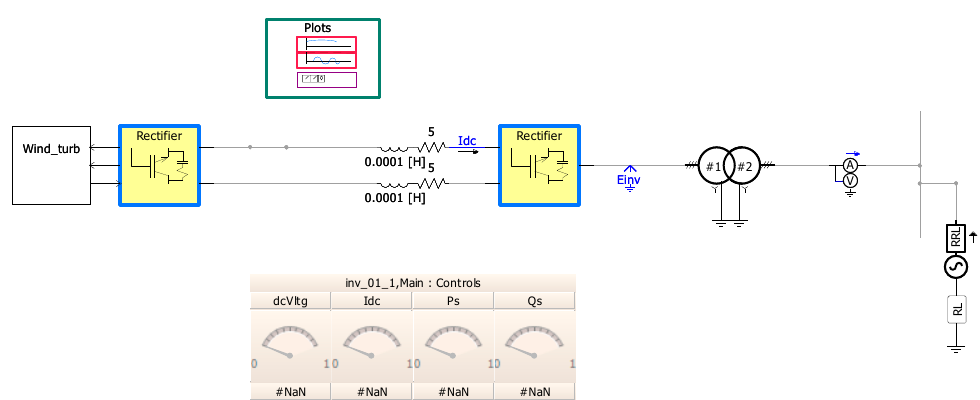
9 of 26 Figure 9. Schematic diagram of the doubly-fed wind power generation system. According to Bates’s theory, the calculation formula of the wind energy utilization coefficient